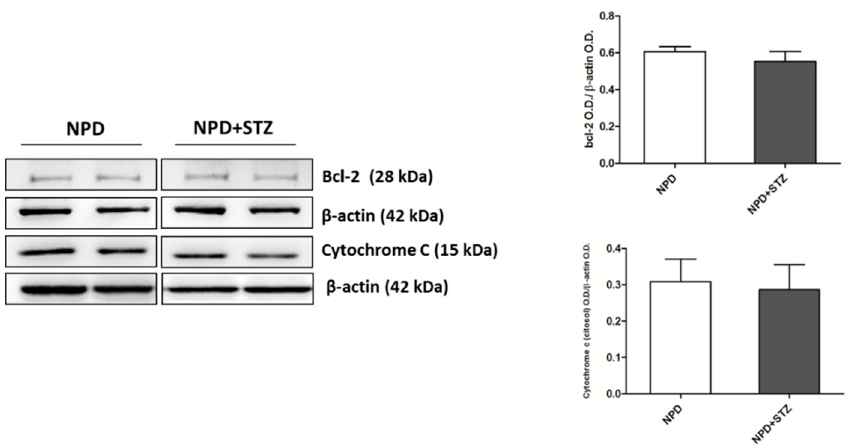
Figure 5. Bcl ‐ 2 and cytochrome C expression in hyperglycaemic and normoglycaemic animals. Western blot analysis showed no changes in Bcl ‐ 2 and cytochrome C expression between the two groups. On the left, representative images of Western blot assay; on the right, densitometric analysis. The data are presented as mean ± SEM. n = 6/group (t ‐ test).